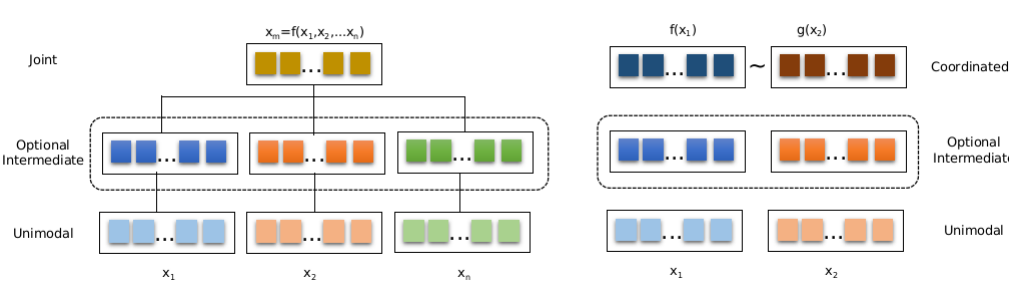
Figure 1. Multi-modal